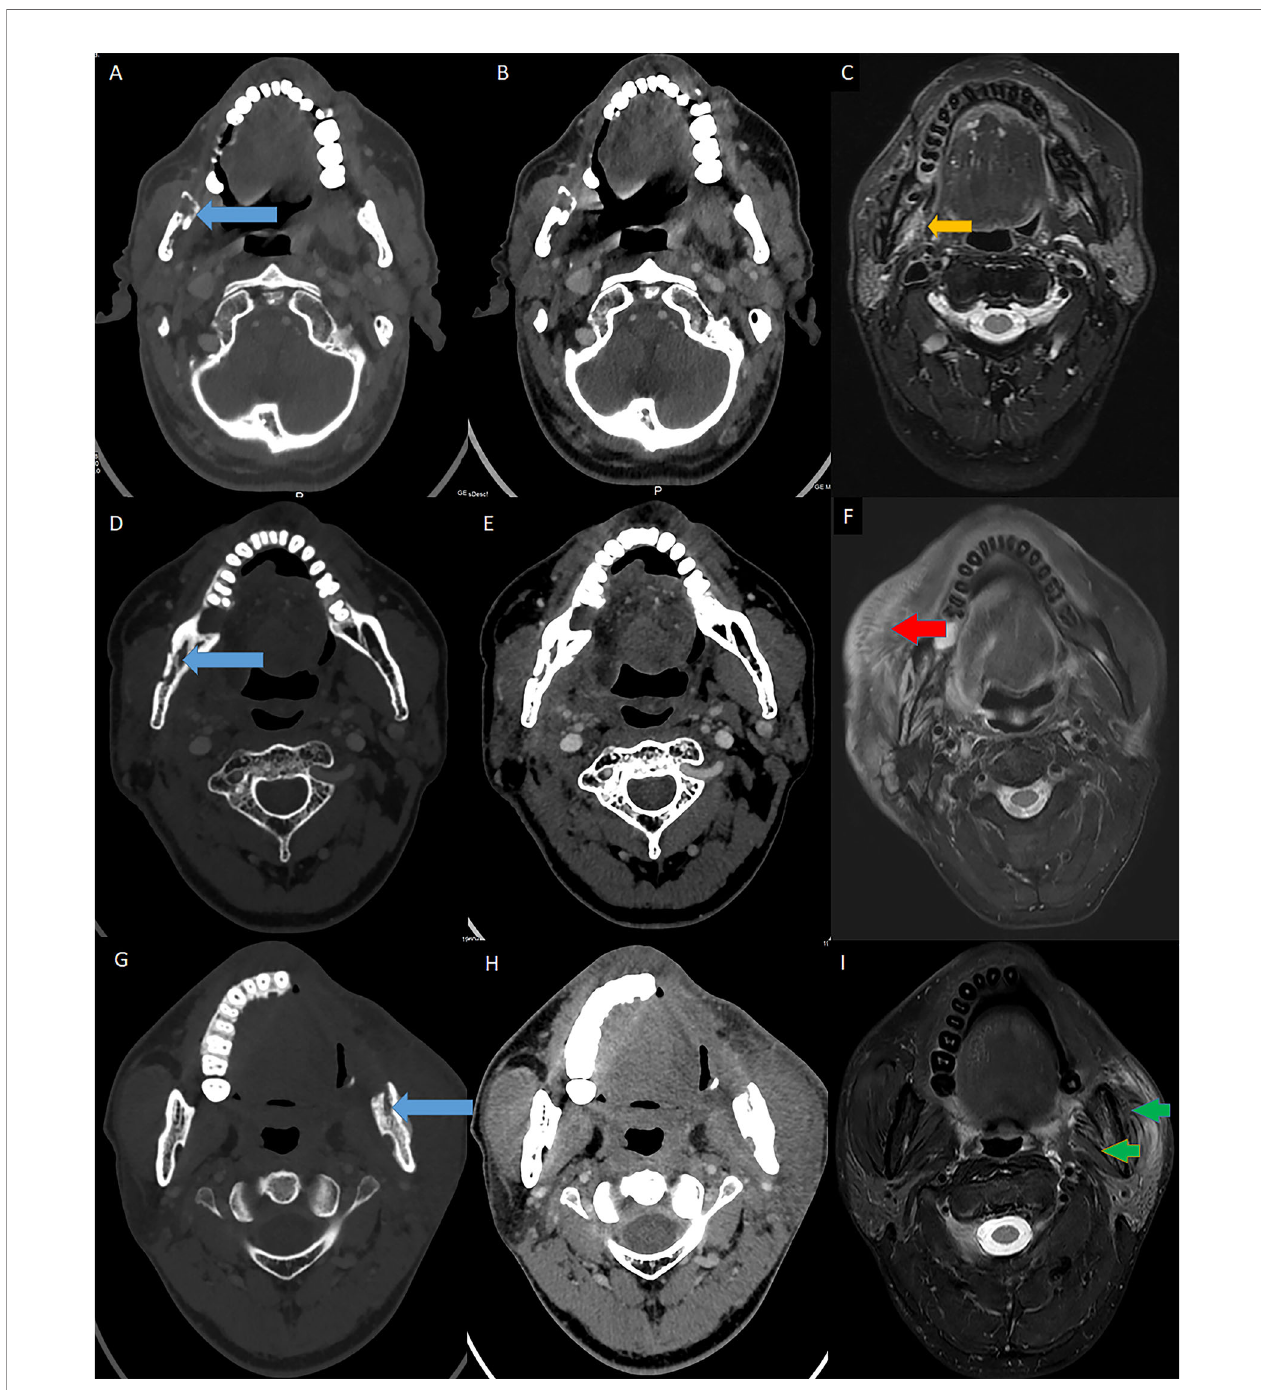
FIGURE 3 | MRI evidence for muscular STI in ORN patients. Blue arrow: ORN lesions; Orange arrow: muscular hypertrophy; Red arrow: muscular edema; Green arrow: muscular atrophy. (A) The axial enhanced CT (bone window) showed the ORN lesion in the ramus. (B) The axial enhanced CT (soft-tissue window) revealed both the ORN and soft tissue content. (C) The axial T2-weighted MRI showed hypertrophy in the pterygoid muscles due to STI. (D) The axial enhanced CT (bone window) showed the ORN lesion in the body and ramus (the second patient). (E) The axial enhanced CT (soft-tissue window) revealed both the ORN and soft tissue content (the second patient). (F) The axial T2-weighted MRI showed edema in the ipsilateral masseter muscles due to STI (the second patient). (G) The axial enhanced CT (bone window) showed the ORN lesion in the ramus (the third patient). (H) The axial enhanced CT (soft-tissue window) revealed both the ORN and soft tissue content (the third patient). (I) The axial T2-weighted MRI showed atrophy in both the pterygoid and masseter muscles due to STI (the third